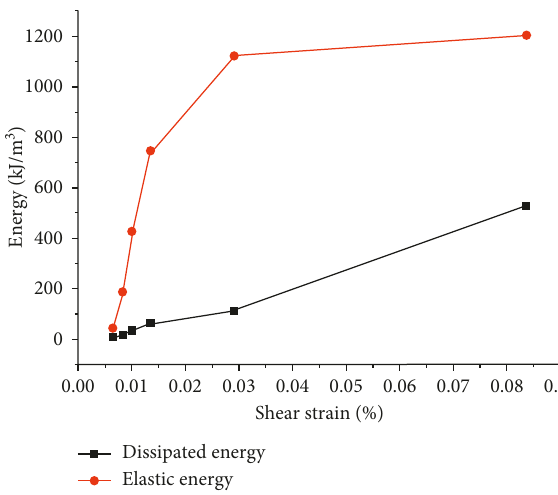
Figure 7: The elastic energy and damage energy corresponding to different damage points at each shear strain under the confining pressure of